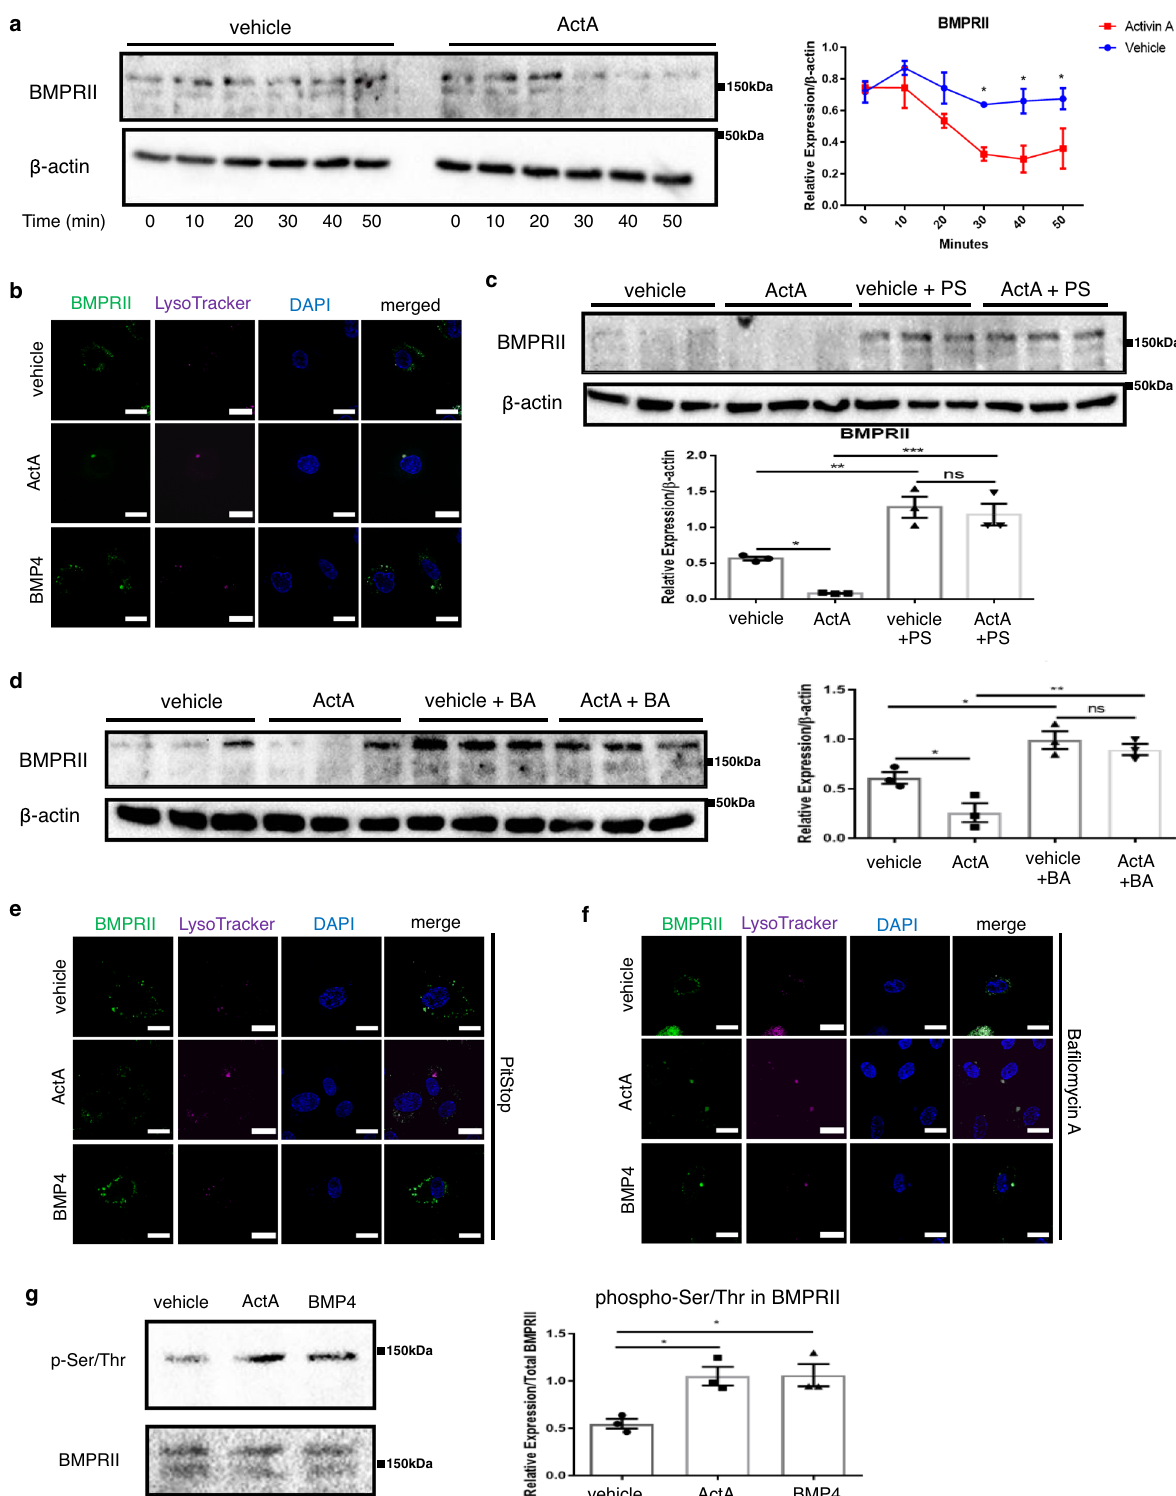
been reported to be lethal in mice, we generated EC-speci fi c conditional INHBA knockout (INHBA-ECKO) mice by mating INHBA- fl ox and VEcad-Cre-Tg mice, to further analyze the role of INHBA/ActA-mediated angiocrine in PAH. INHBA-ECKO mice were viable and fertile, and there were no signi fi cant dif- ferences in body weight between INHBA- fl ox and the INHBA- ECKO mice both in neonates and adults (Supplementary Fig. 7a).